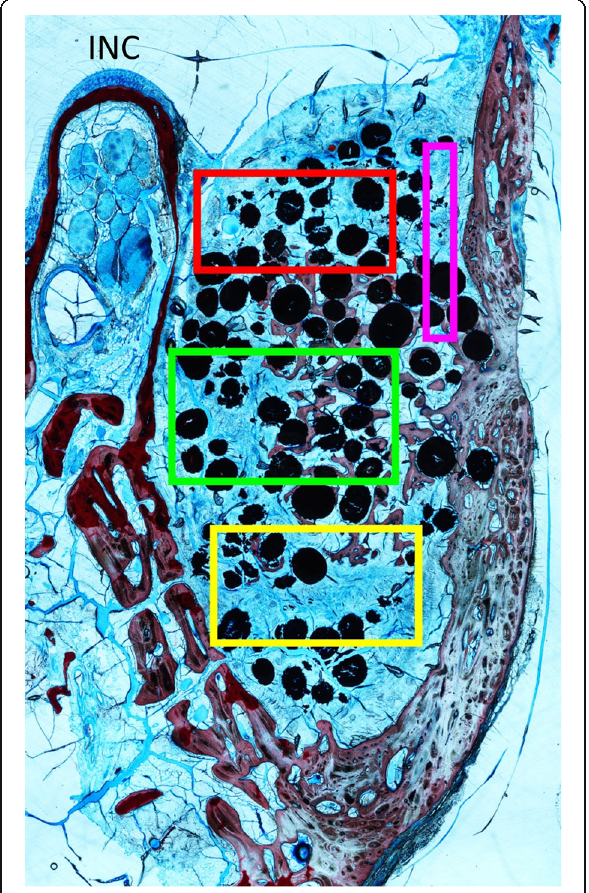
morphometric analysis. RED: submucosa; GREEN: middle; YELLOW: base; PURPLE: close-to-window. INC: top of the infraorbital nerve